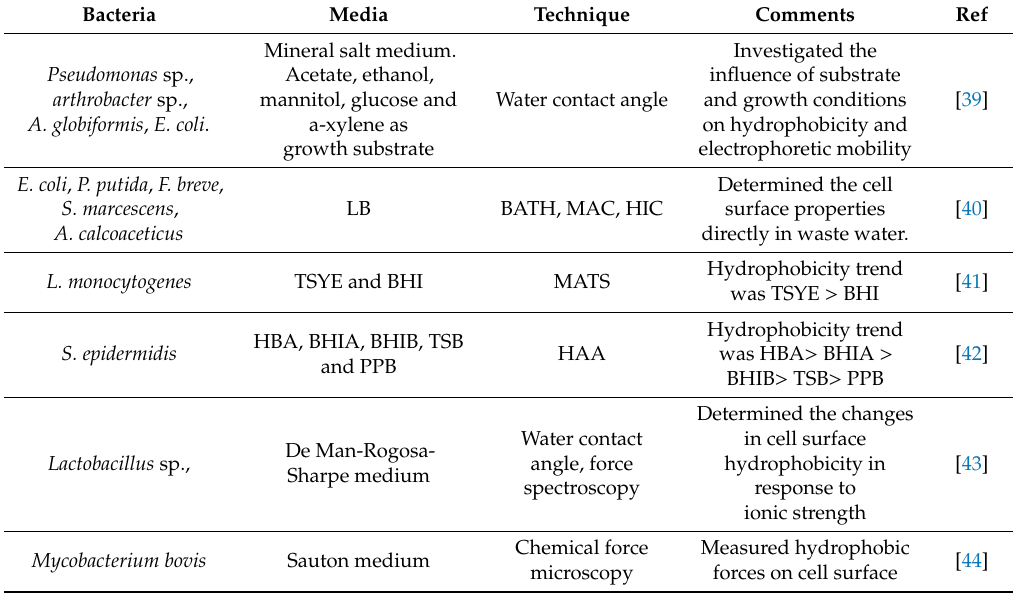
Table 1. E ff ect of growth conditions on